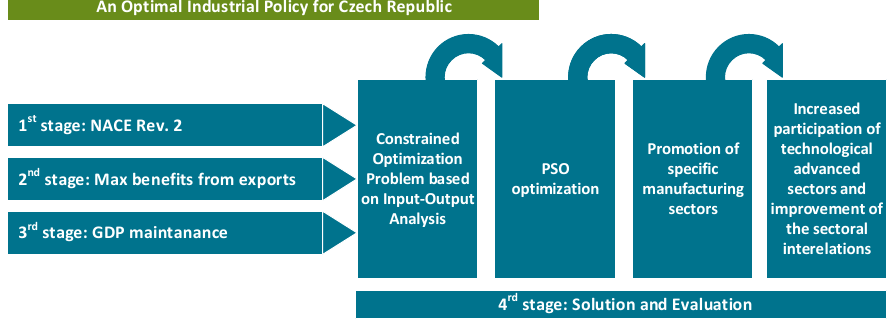
Figure 2. A graphical presentation of the methodological approach for the Czech Republic.